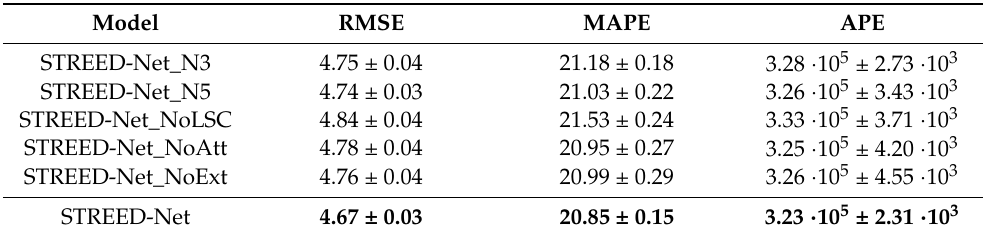
Table 4. Results obtained from ablation studies.